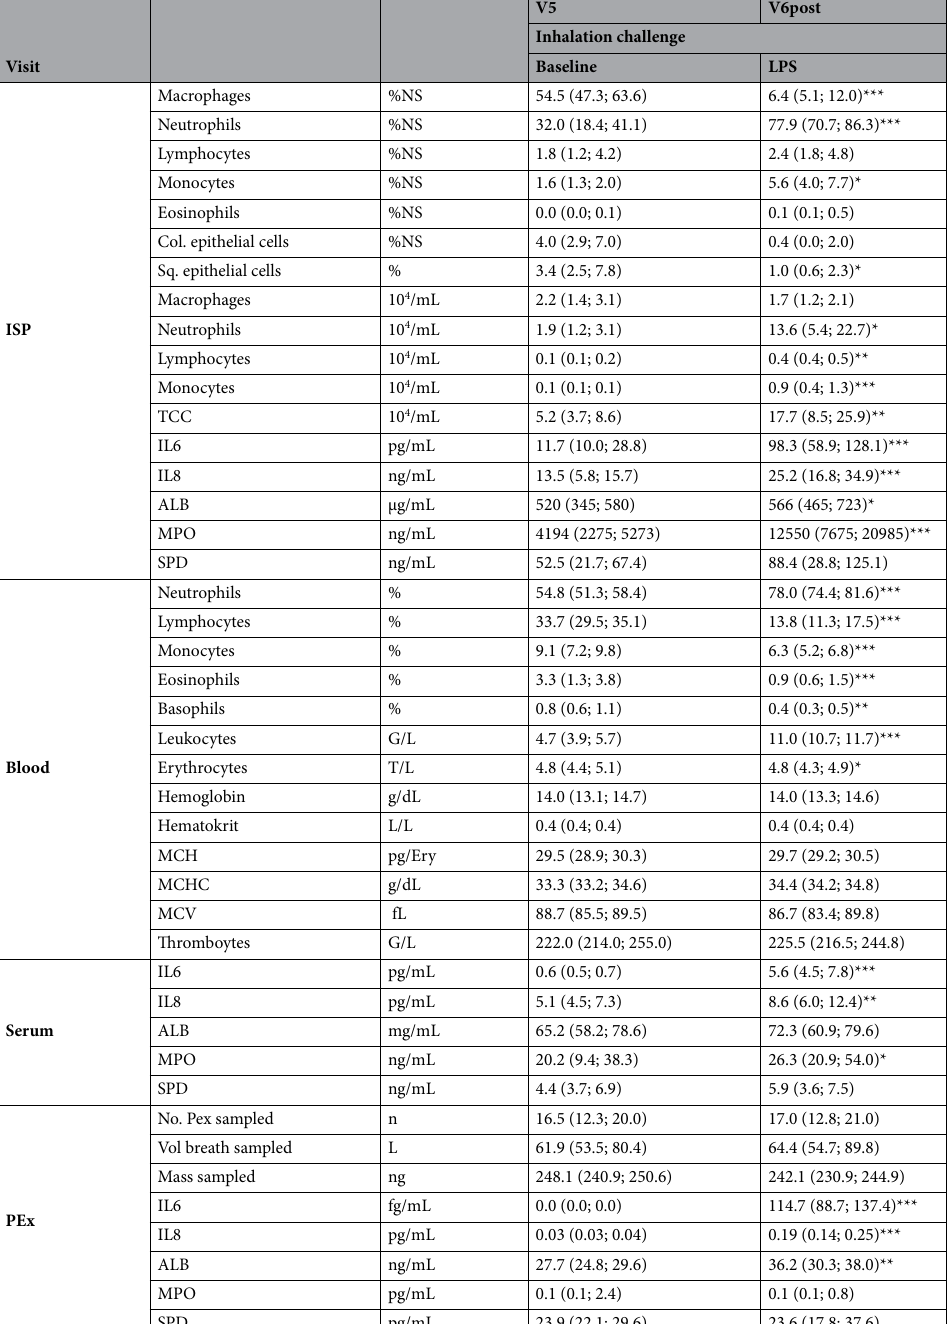
Table 2. Summary of the inflammatory response in induced sputum, blood/serum and PEx for inhalation LPS challenge (V5–V6). PEx: concentration in 200 µL eluat from a half a filter membrane (PEx mean mass 120 ng). Concentration*0.2/120 ng will give the estimated concentration in ELF. %NS % nonsquamous cells. *p < 0.05,**p < 0.01,***p < 0.001. Median and